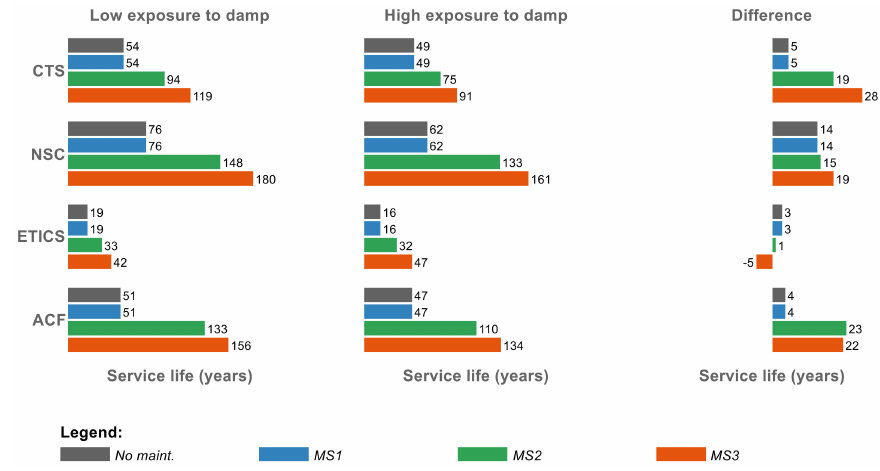
Figure 3. Comparison of the service life according to exposure to damp.